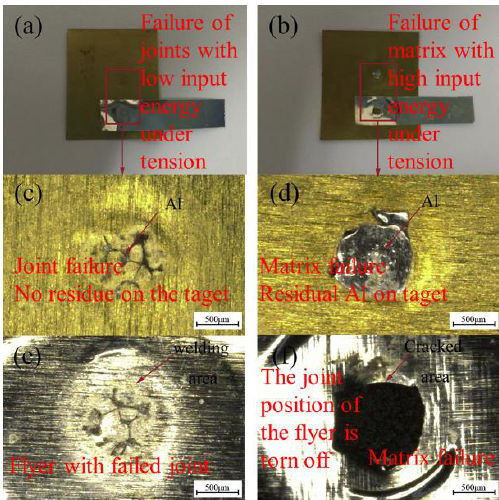
Figure 16. Two forms of failure (reproduced from [27], with permission of Elsevier 2019) ( a , c , e ) Low-energy joint failure; ( b , d , f ) High-energy base metal failure.